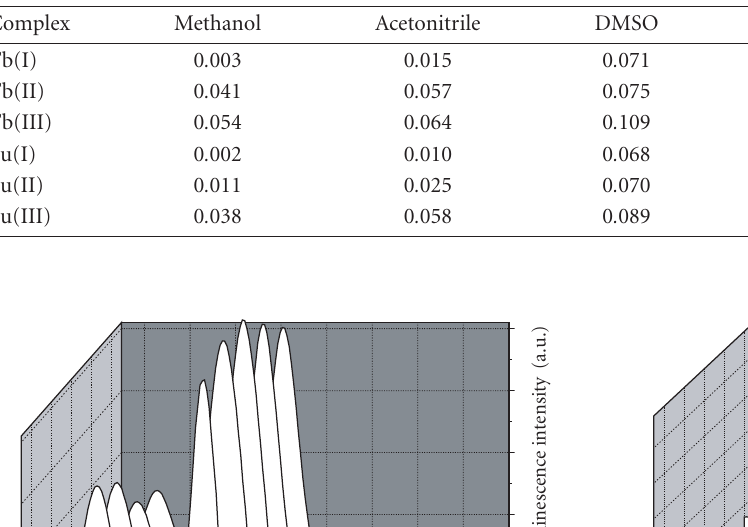
Table 3: Quantum yield values of 8 5%). ( (cid:3)